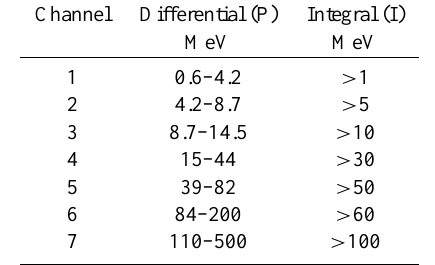
Table 1. Corrected differential and integral proton flux channels from the EP8 instrument on board the GOES-8